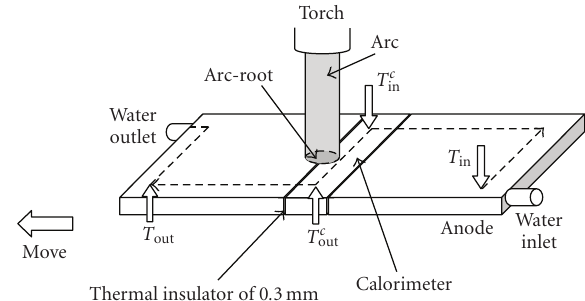
Figure 6: Anode assembly and calorimeter to measure the heat